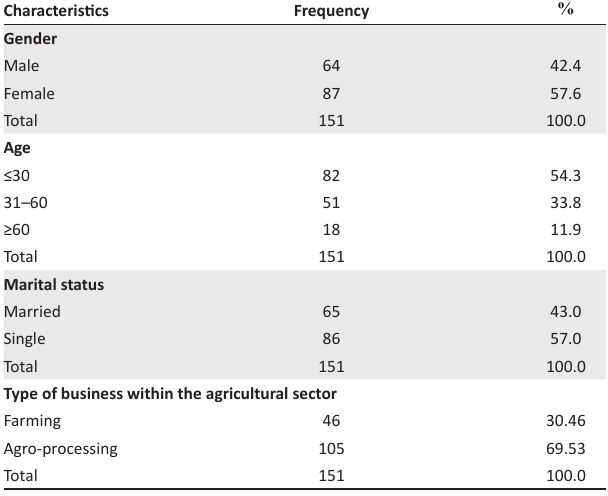
TABLE 1: Sample demographic